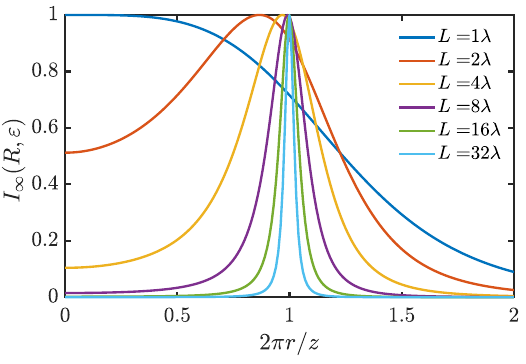
Figure 3. Far-zone intensity (normalized to its maximum value) for several values of ε . Using now physical quantities ( L and P ) we look at the intensity plots when P is kept fixed and L is varied. (see Figure 4).